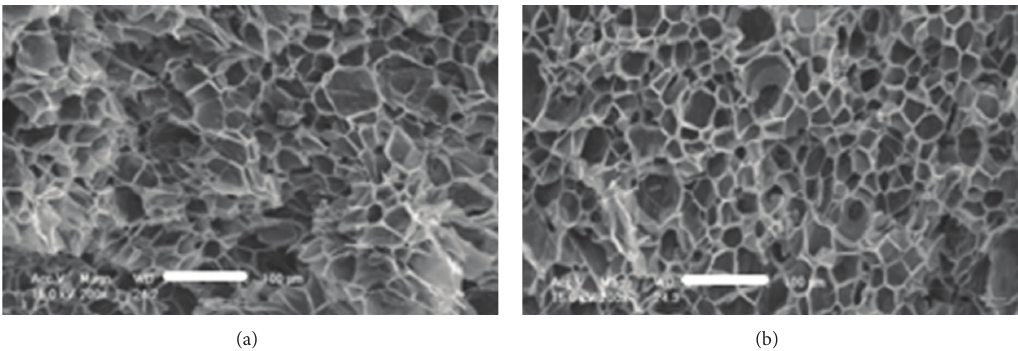
Figure 2: Scanning electron microscope (SEM) of surface structure of wood/PP composites with (a) 20% APP flame retardant and (b) 20% APP & 10% silica flame retardant [54].